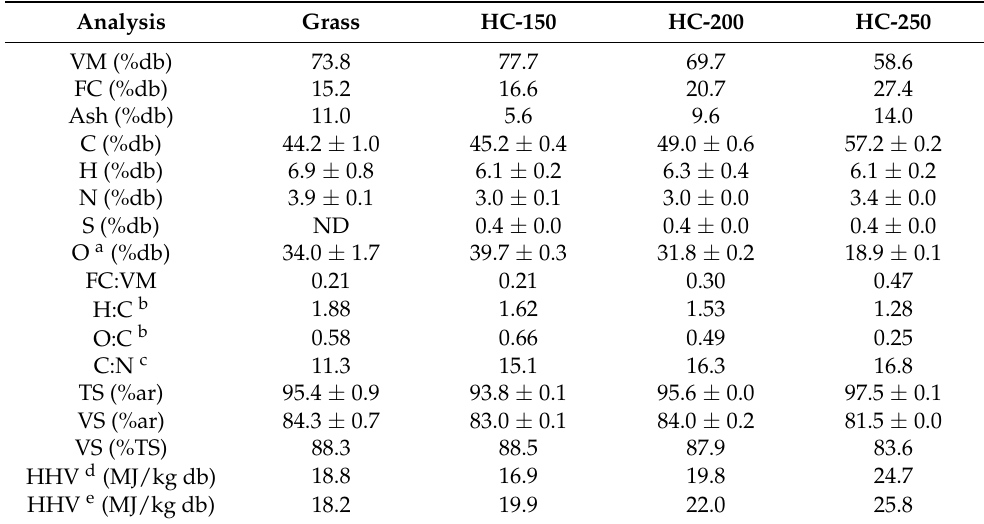
Table 2. Proximate and ultimate composition of grass and